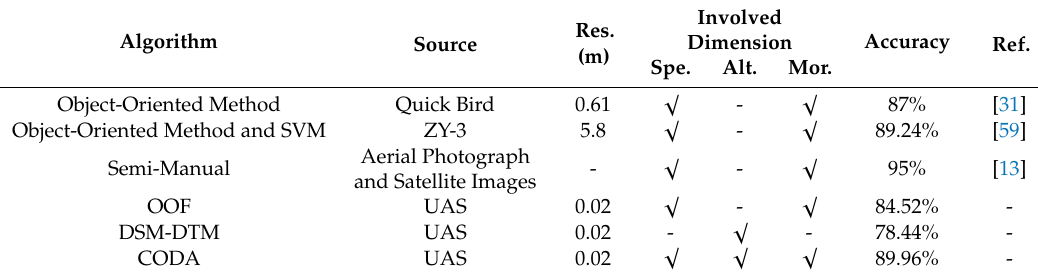
Table 7. The contrast of several di ff erent recognition methods for shrubs.